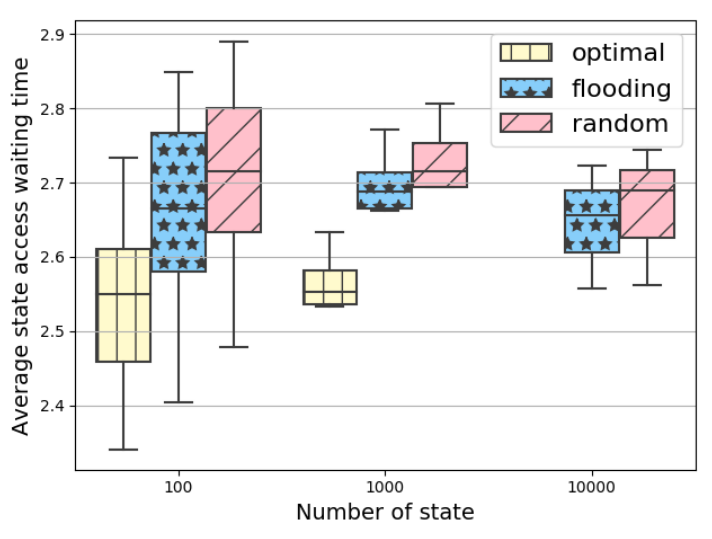
Figure 5. Performance of the optimal, flooding, and random heuristics depending on the number of servers. Since the optimal from 10k states exceeds the one-hour time limit, its results are presented up to the input of 1k states.